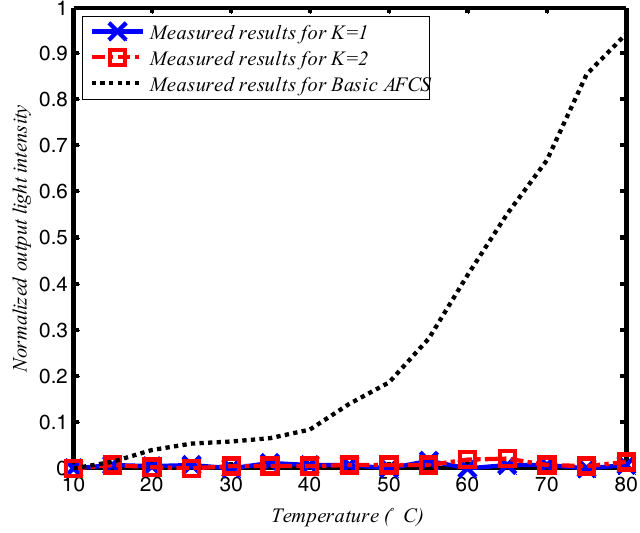
Figure 5. The effect of temperature on the loop AFCS based on the SPSM couplers.